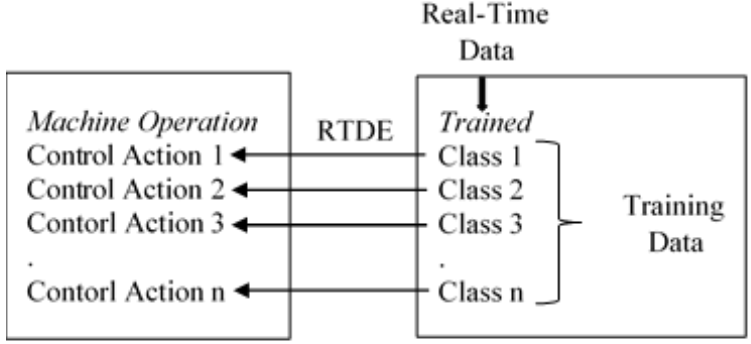
Figure 7. CPS framework that can operate on object detection and control algorithm (ODCA).